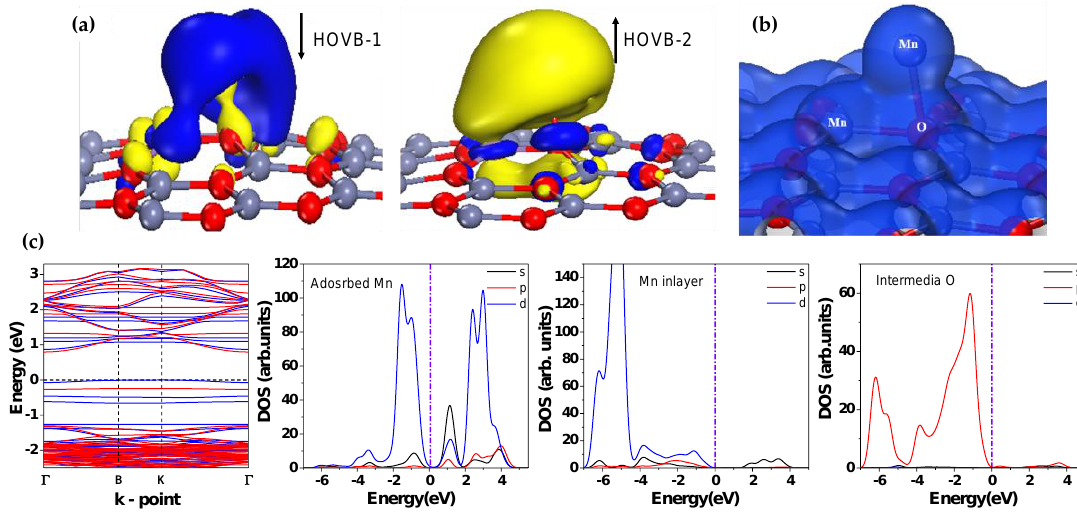
Figure 4. Orbitals of the highest occupied valence band (HOVB) in the Mn adsorbed-doped ZnO monolayers ( a ); electronic charge density ( b ); and electronic structures ( c ) [82]. Copyright © (2017) American Chemical Society (ACS), http://pubs.acs.org/doi/full/10.1021/acsomega.7b00093. Reproduced with permission from ACS. Further permission related to the excerpted material should be directed to the ACS.